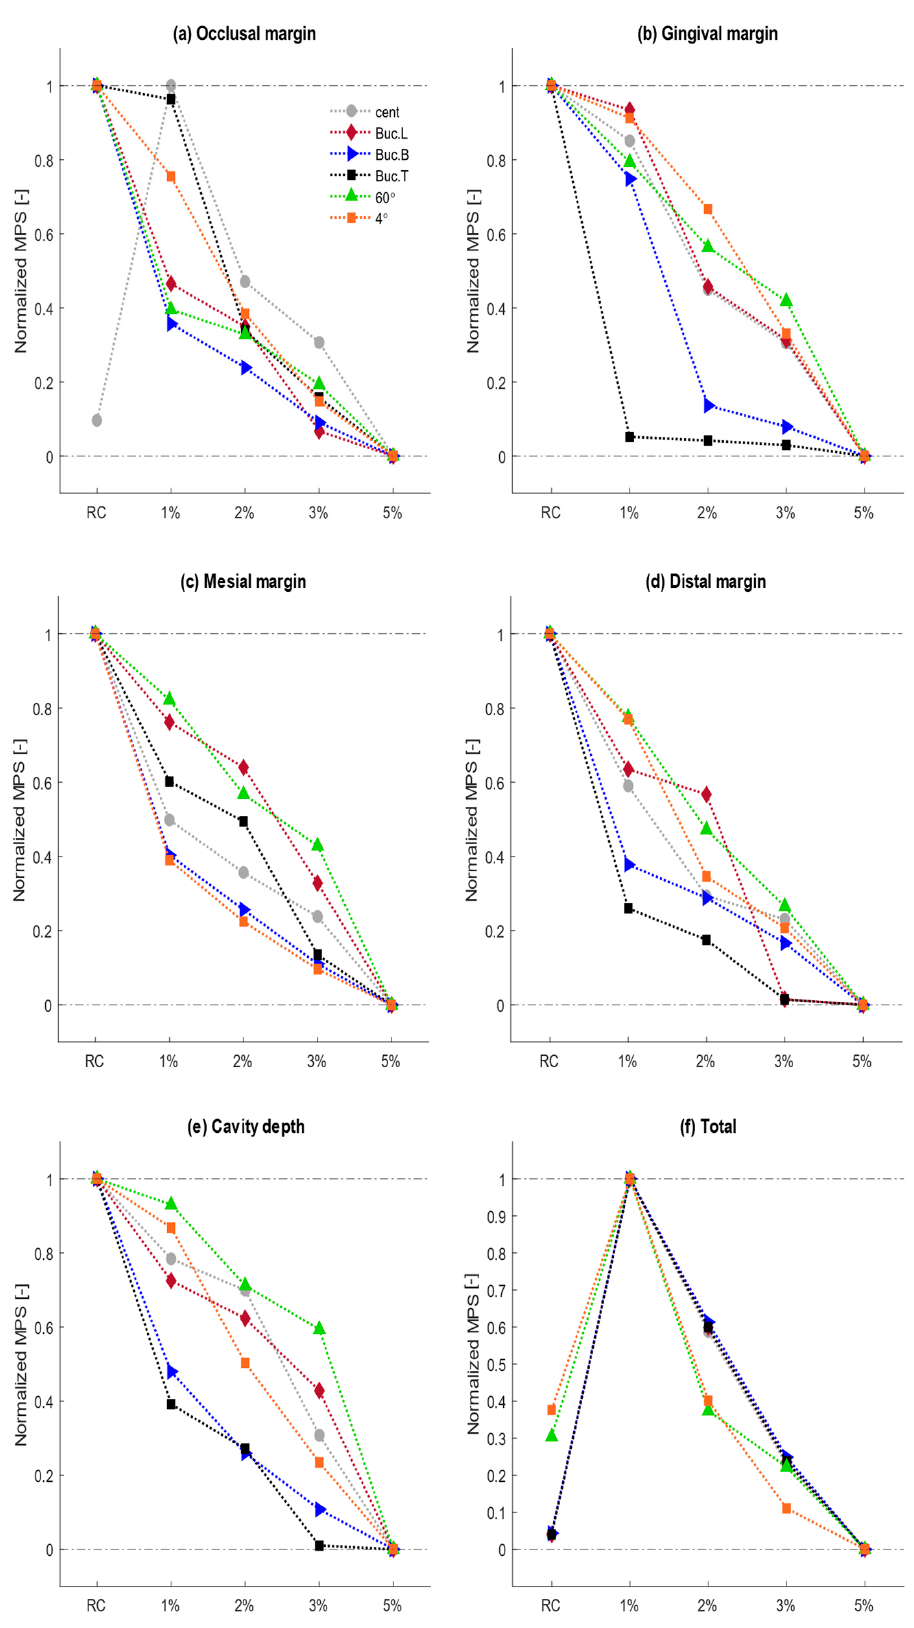
Figure 5. Normalized changing trend of MPS values created among various incorporation ratios of ZnO NPs in various boundary ZnO NPs in various boundary conditions.